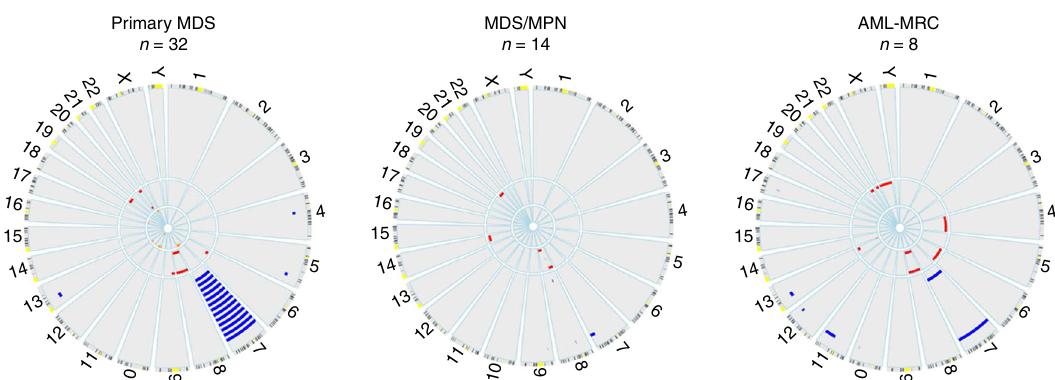
Fig. 3 Copy number analysis. Circos plots showing copy number alterations found with WES analysis of 54 tumor-normal pairs (events identi fi ed by conventional karyotyping are not included in these plots). Circumferential numbers indicate chromosome number, blue lines (outside ring) = deletions, red lines (middle ring) = ampli fi cations, and orange lines (inside ring) = copy number neutral-loss of heterozygosity